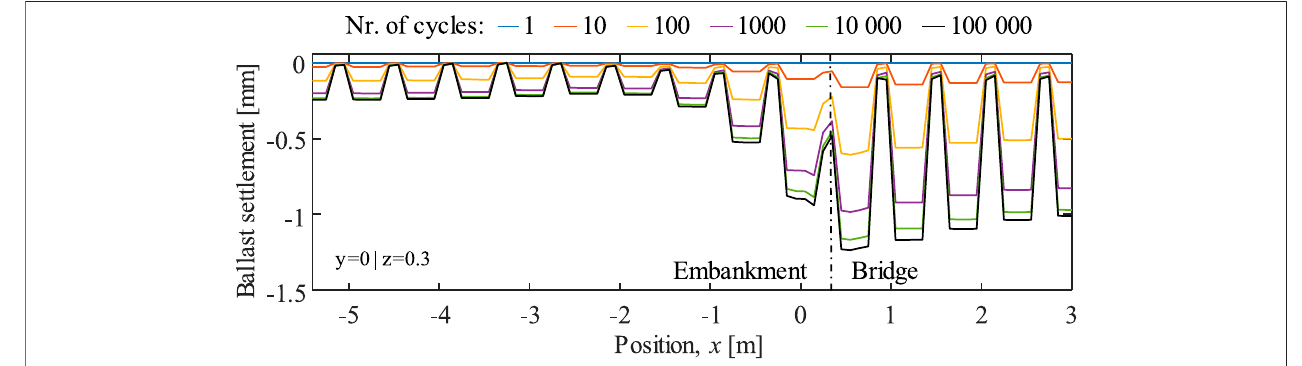
FIGURE 8 | Evolution of the ballast settlement (longitudinal pro fi les) with N, assessed at y (cid:1) 0m and z (cid:1) 0 . 3m (under the sleepers ’ base level, at the track CL).